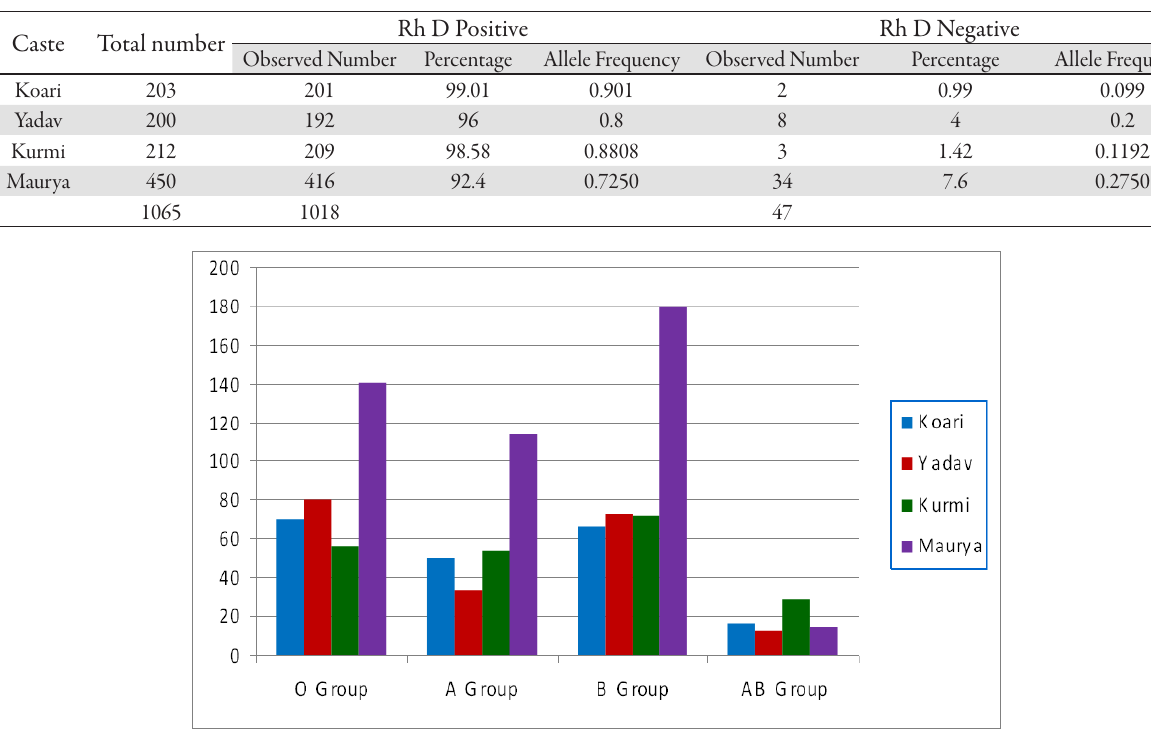
Tab. 9. Rh blood group among OBC